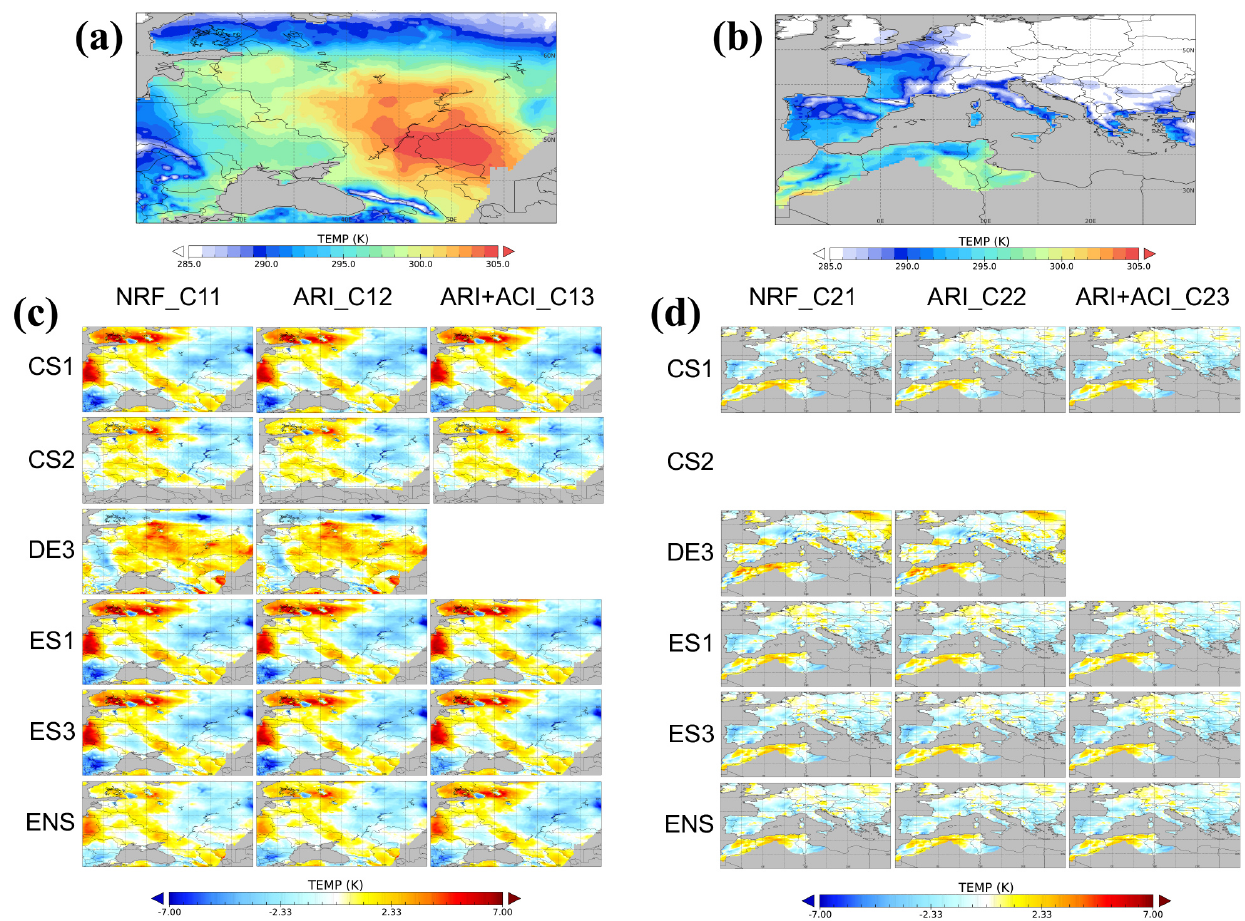
Figure 3. Mean temperature (TEMP) for the fire (a) and dust (b) episodes, as derived from the E-OBS database (in K). The panels below represent the bias for the fire (c) and dust (d) episodes of each simulation with respect to the E-OBS